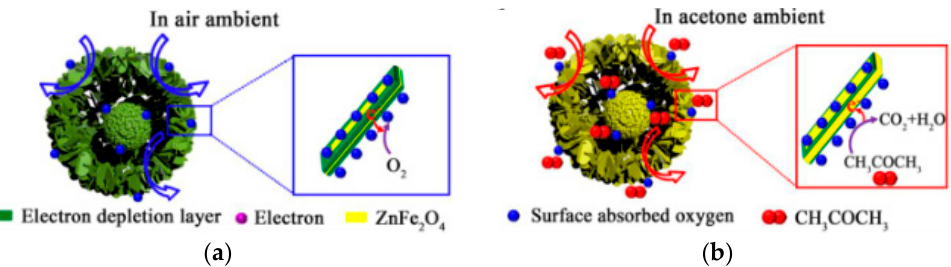
Figure 11. Schematic diagram of possible reasons why ZnFe 2 O 4 core-shell microspheres exhibit higher acetone response ( a ) contact with air; ( b ) contact with the aimed gas [47].